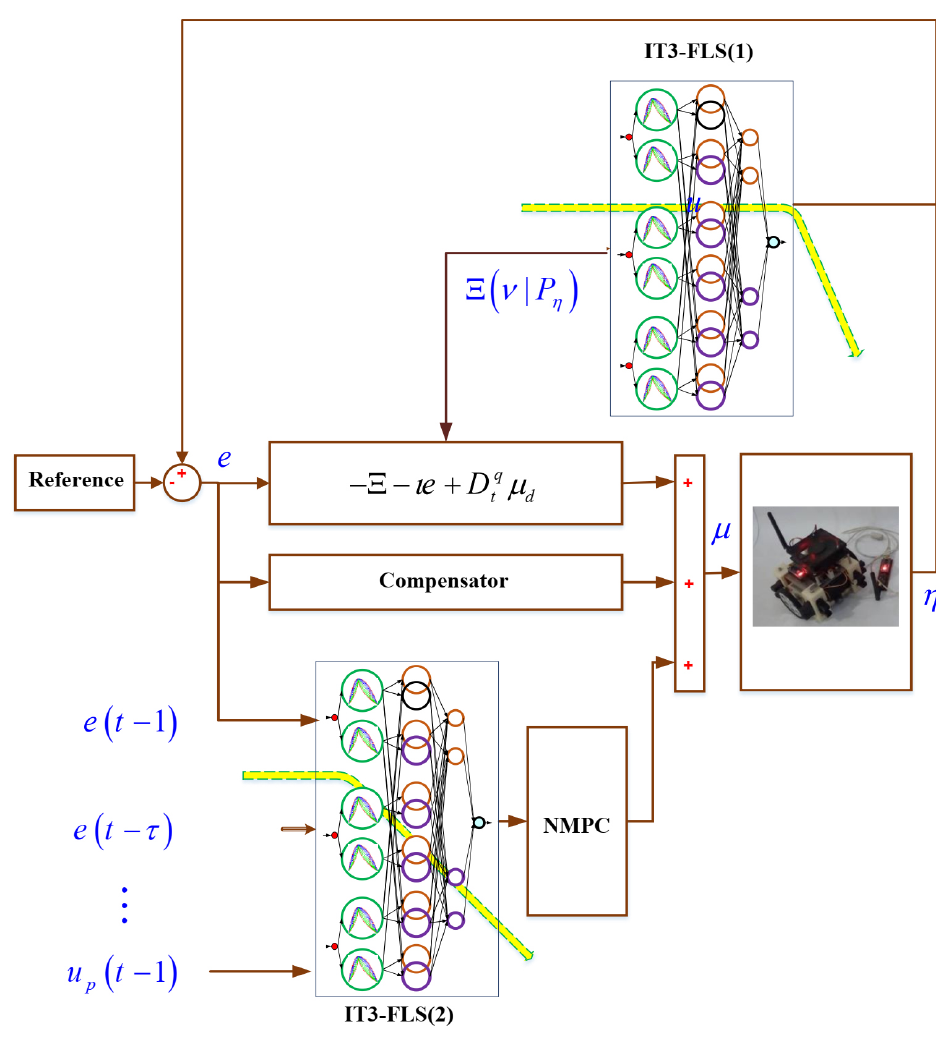
Figure 2. Suggested control